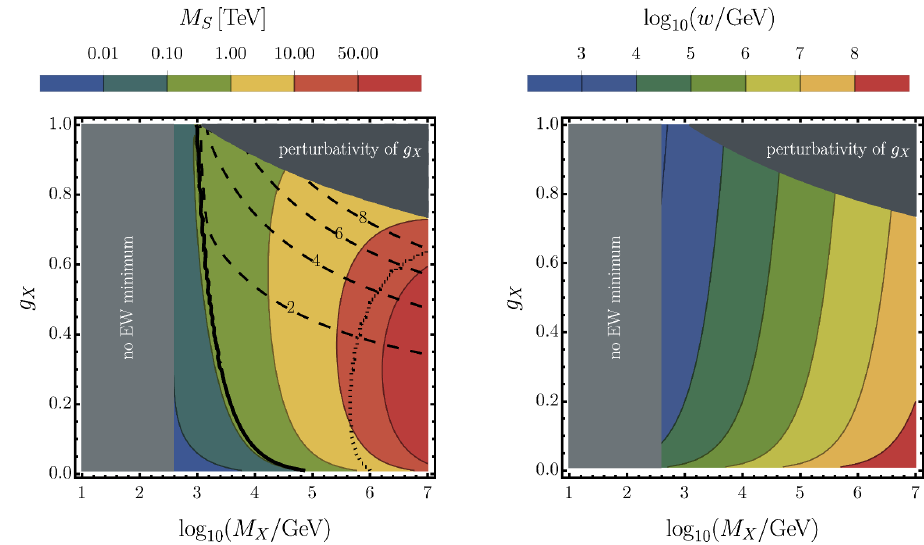
= M = 125 GeV and across S H , and to the right S < M H